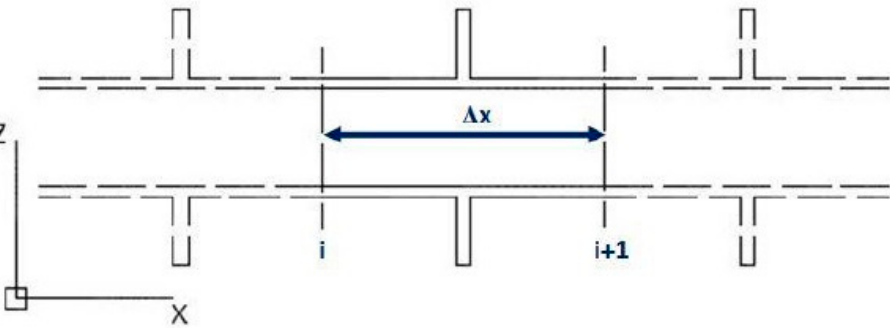
Figure 8. Schematic structure of a finned cell, considering only one fin. The finned cell is identified by the integration step, ∆ x, which represents the length of the i -th finned cell, and the height of the fins, which also represents the height of the i -th finned cell. The refrigerant flows inside the tubes along the x-direction. The supply tubes are arranged along the z-direction.